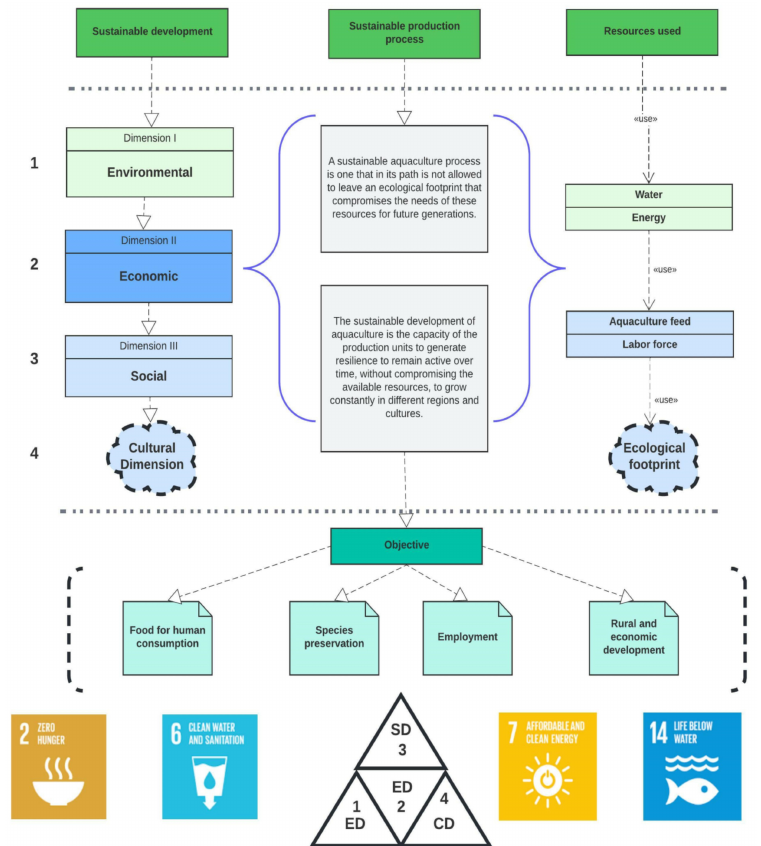
Figure 15. Principles of sustainable aquaculture and sustainable development objectives related to aquaculture.